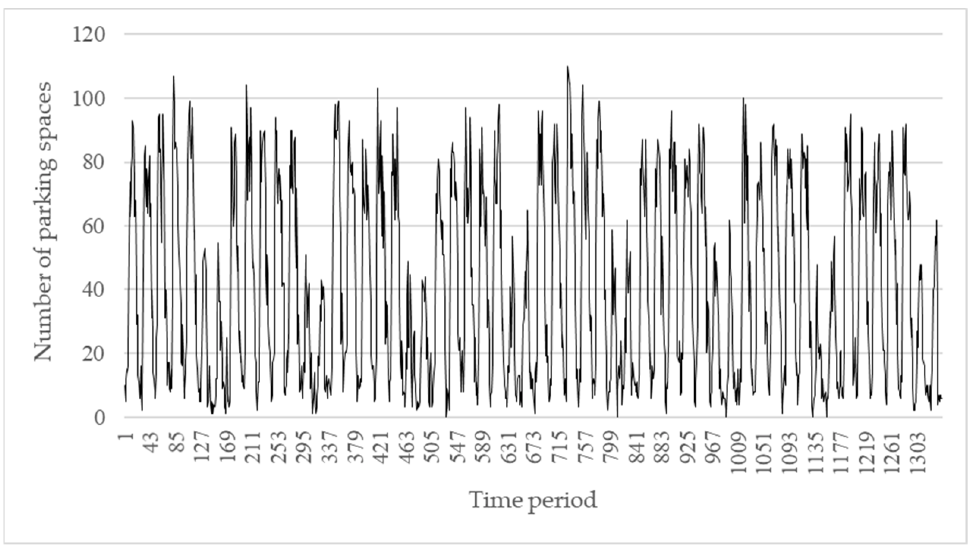
Figure 13. Artificial dataset.